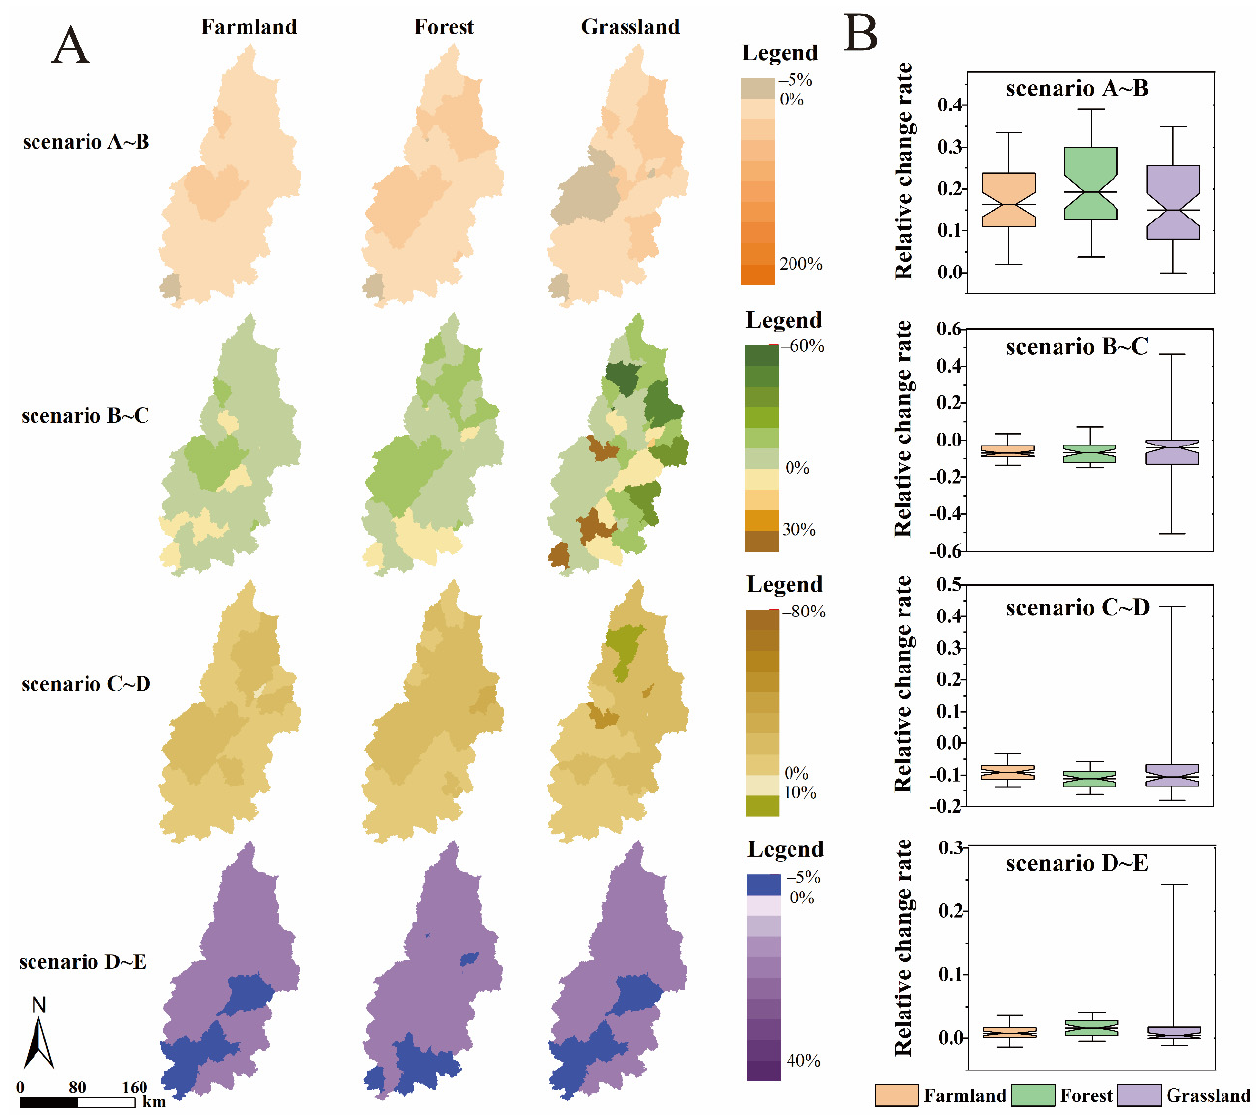
Figure 6. Relative change in WCA of each ecosystem under land use change scenarios (wet season). ( A ) Spatial distribution of WCA evolution for each ecosystem; ( B ) relative rate of change in WCA for each ecosystem.